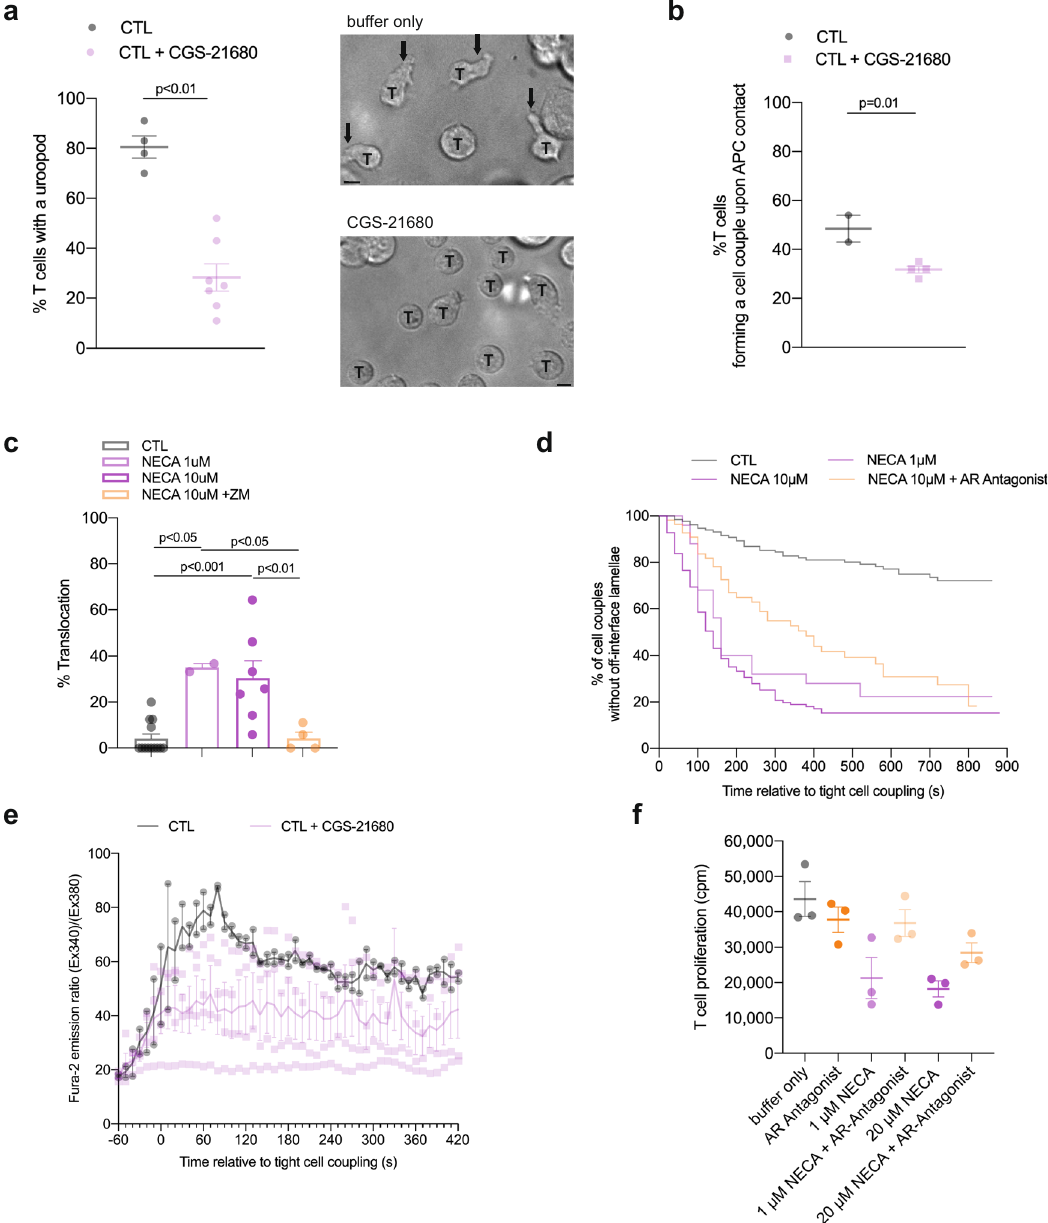
Fig. 7 A 2A R suppresses the cytoskeletal polarization of CTL. a Percentage of in vitro CL4 CTL with a uropod±1 µ M CGS-21680±SEM. N = 4 independent experiments, 220/648T cells analyzed. Representative images of CL4 T cells (labeled with ‘ T ’ ) in a fi eld with Renca APC treated ±1 µ M CGS-21680. Arrows indicate uropods. Scale bar = 5 µ m. b Frequency of CL4 T cells that form a tight cell couple upon contact with a Renca APC incubated with 2 µ g/ml K d HA peptide±SEM. N = 2 independent experiments, 68/234T cells analyzed. c , d Imaging of the interaction between in vitro CL4 CTL with K d HA-pulsed Renca tumor cell targets treated with NECA ±1.25 μ M A2aR antagonist ZM 241385. c Percentage of cell couples with translocation (1-way ANOVA) ±SEM. N = 28- 132 cell couples per condition over ≥ 2 experiments. Alternate analysis of pooled data by proportion ’ s z -test yields p <0.001 for all comparisons between NECA only-treated and control or ZM 241385-treated samples. d Time until the formation of fi rst off-interface lamella (Kaplan – Meier survival analysis (Log Rank)). P <0.01 all comparisons. e In vitro CL4 CTL interacted with RencaHA cells incubated with 2 µ g/ml K d HA peptide ± 1 µ M CGS-21680. The ratio of Fura-2 emissions at 510nm upon excitation at 340nm over 380nm is given relative to time of tight cell coupling as the mean±SEM. N = 2 independent experiments, 13/42T cells analyzed. f CL4 T cells were primed in vitro using anti-CD3/CD28 mAb. NECA±1.25 µ M ZM 241385 were added at 0h and 3 H-thymidine for the last 8h of cell culture. Proliferation was quanti fi ed by 3 H-thymidine incorporation (cpm) and is given as the mean±SEM ( N = 3 experiments). Source data are provided in Supplementary Data 6 (all but the calcium data) and Supplementary Data 7 (calcium